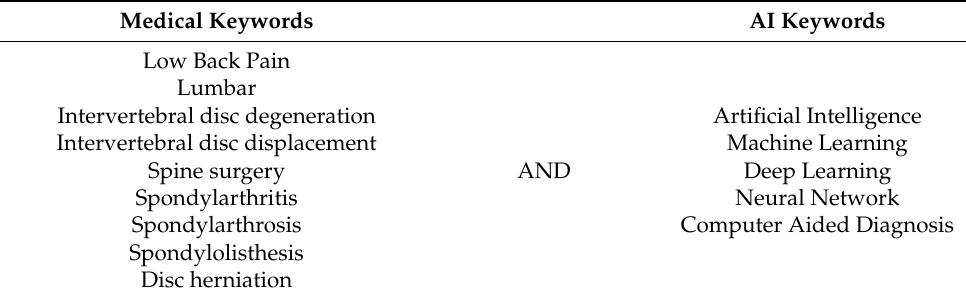
Table 1. Summary of the search words used on the PubMed research. The words in the medical or the AI group are connected by a logic OR, whereas the two groups of words are connected with a logic